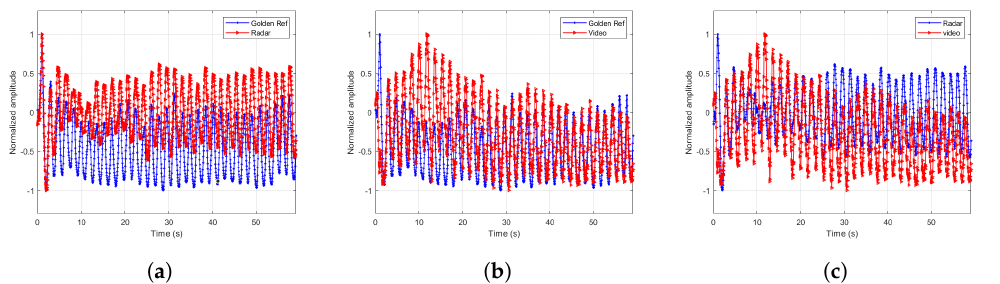
Figure 9. Extracted signals comparisons for breathing rate of 33.98 BPM. ( a ) Radar and ground truth signals. ( b ) RGB and ground truth signals. ( c ) Radar and RGB signals.